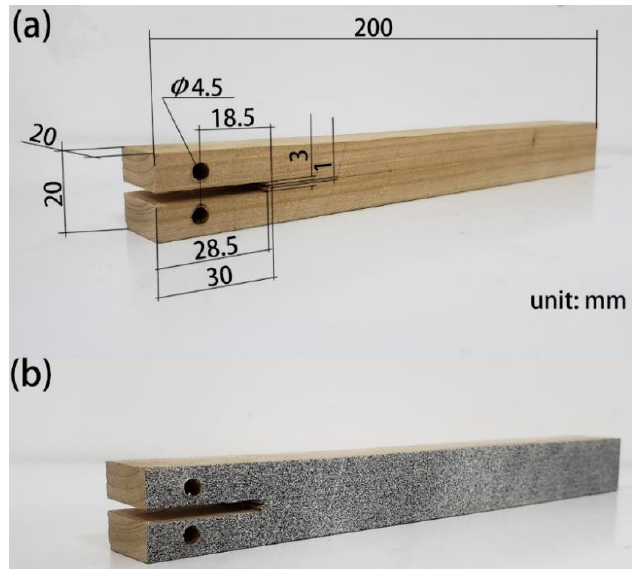
Figure 4. ( a ) Double cantilever beam (DCB) in view of mode I. ( b ) Double cantilever beam (DCB) in view of mode I after painting the speckle.